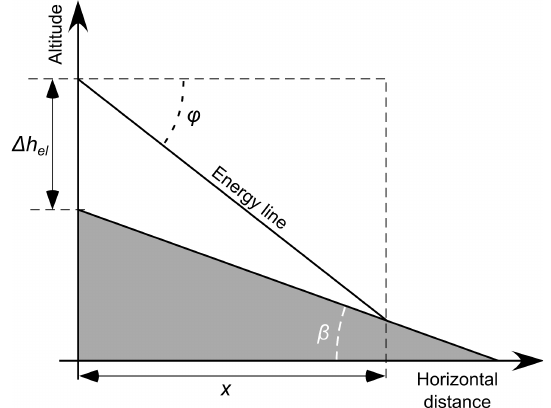
Fig. 15. Relationship between the slope gradient ( β ), the runout dis- tance ( x ) and the friction angle ( ϕ